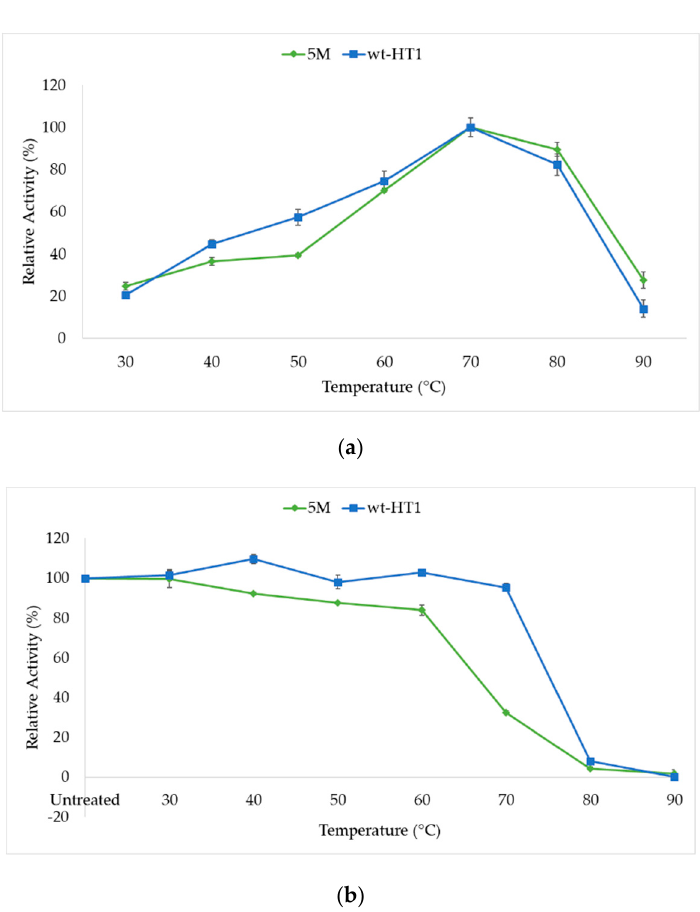
Figure 3. Effects of temperatures on activity and stability of lipases. ( a ) Optimum temperature of wt-HT1 and mutant 5M lipases. ( b ) Temperature stability of lipases from 30 to 90 °C.